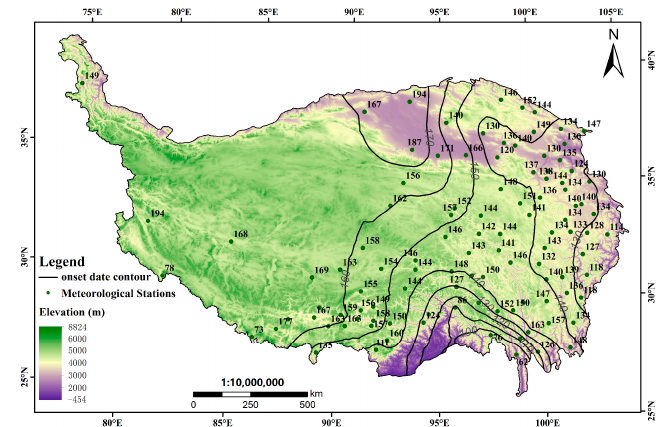
Figure 2. Spatial distribution of rainy season onset on the TP (1971–2015). (Stations are sparse in the western TP; therefore, the five stations in the west were not part of the contour interpolation calculations.).